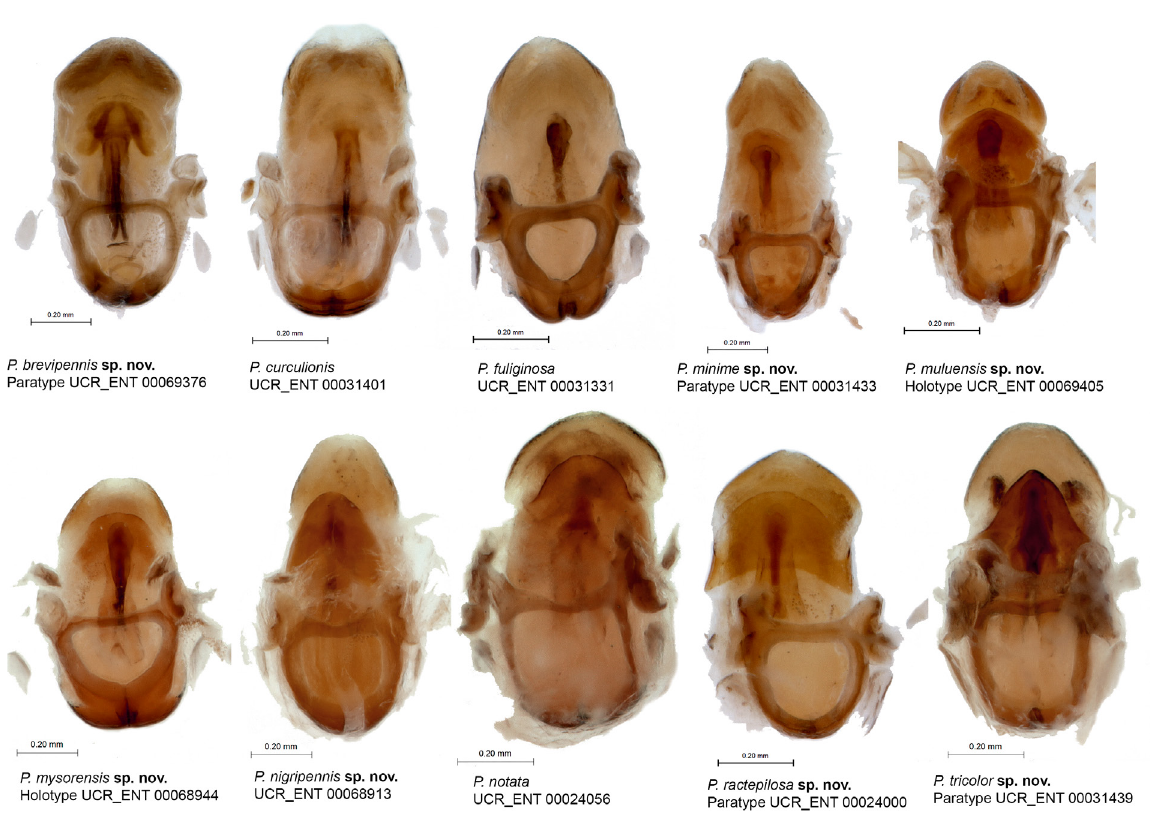
Fig. 19. Dorsal view of the phallus in species of Physoderes Westwood, 1845